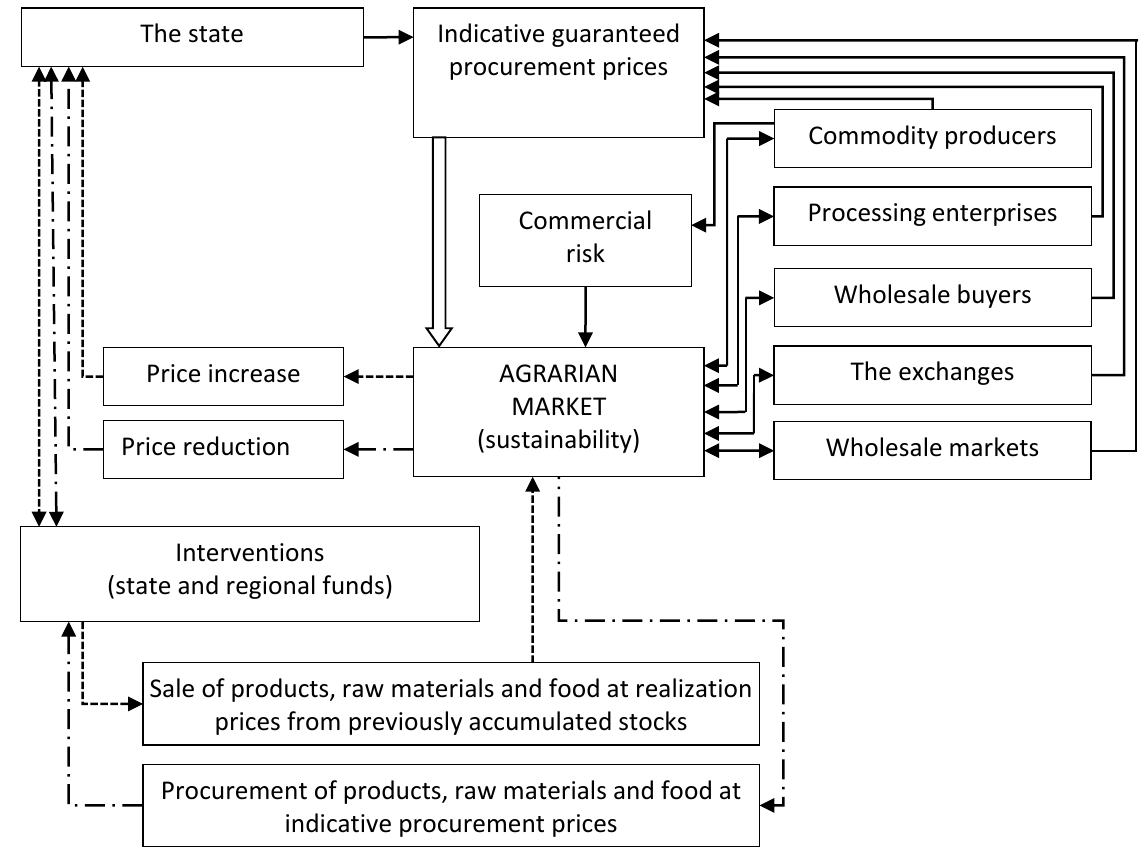
Figure 2. State regulation of prices on agricultural market to ensure the sustainability of its